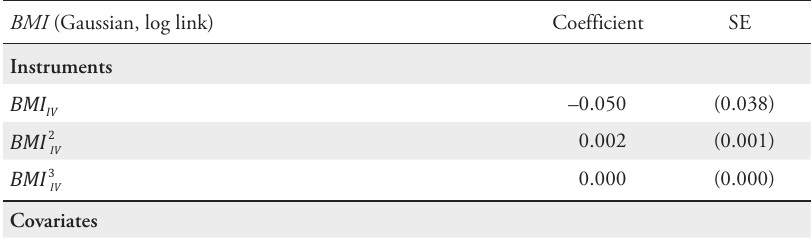
Table 7: Explaining the BMI of